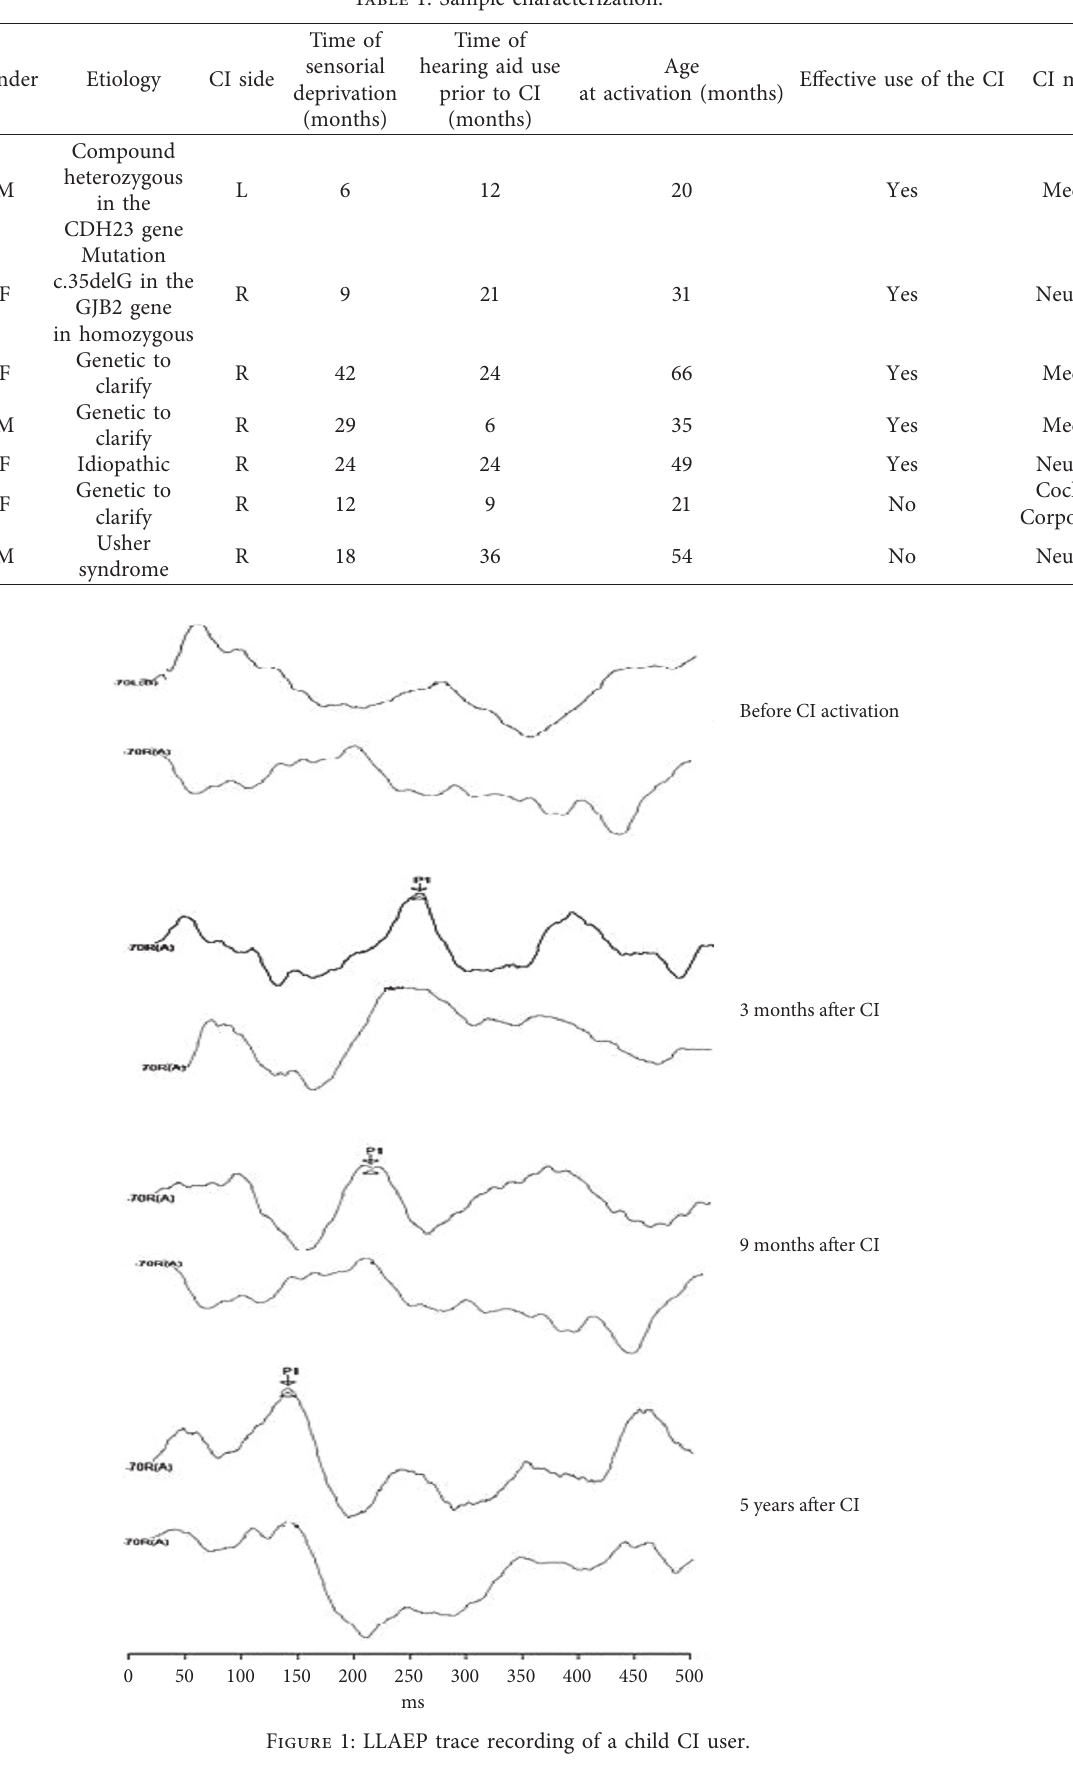
Figure 1: LLAEP trace recording of a child CI user.